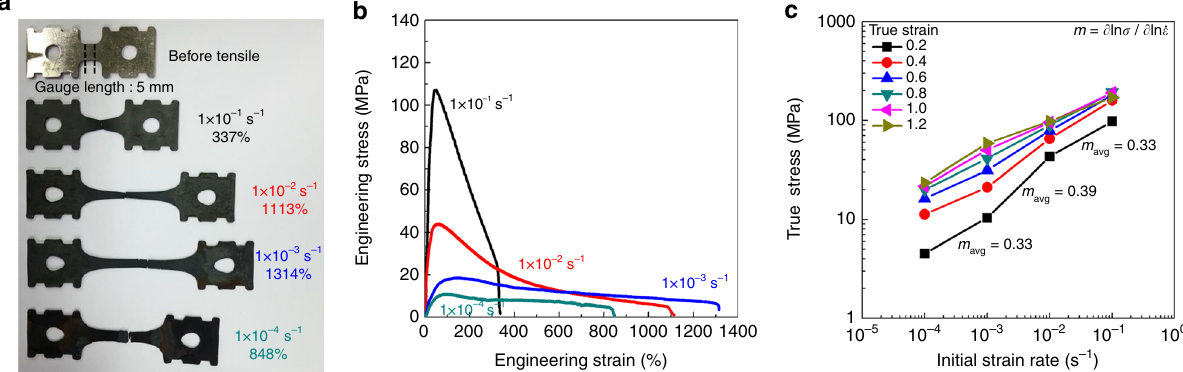
Fig. 1 Tensile properties of Fe-6.6Mn-2.3Al (wt.%) steel at 850 °C. a Images of fractured tensile specimens. b Engineering stress – strain curves of tensile specimens strained at various initial strain rates, ranging from 1.0 × 10 − 4 to 1.0 × 10 − 1 s − 1 . c Variation of true stress with initial strain rate at speci fi c